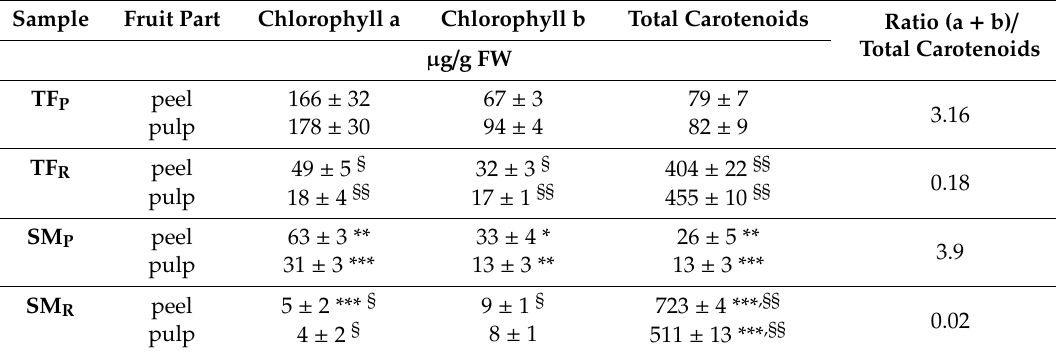
Table 4. Amounts of chlorophyll a, chlorophyll b, and total carotenoids in the organic extracts of both pink and red fruits from Solanum lycopersicum var. Torpedino di Fondi (TF) compared San Marzano (SM) tomatoes a